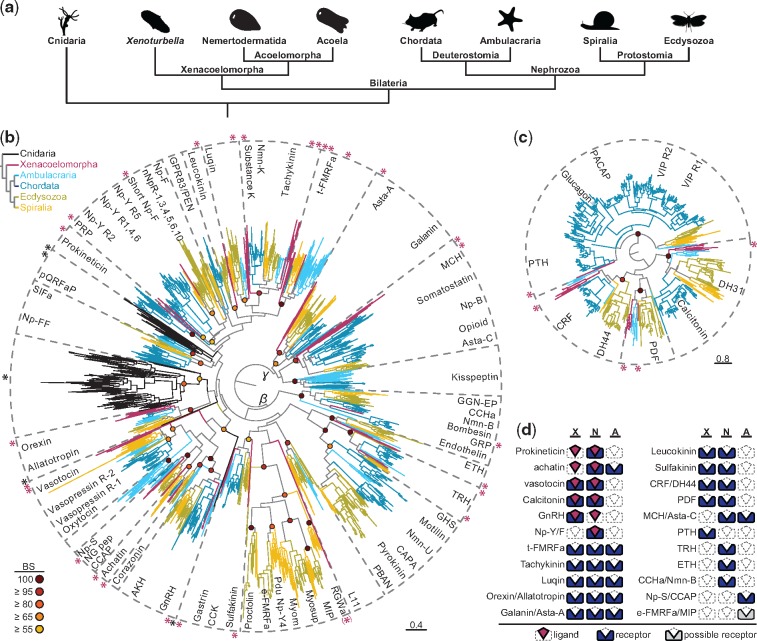
Phylogenetic analysis of neuropeptide GPCRs. (a) Simplified phylogeny of Bilateria with Cnidaria as their sister group. (b) RAxML analysis of rhodopsin type neuropeptide GPCRs. Rhodopsin beta GPCRs are rooted against rhodopsin gamma GPCRs. Bootstrap values of the particular nodes are represented as red-to-yellow circles as shown on the lower left. The scale bar on the lower right indicates amino acids substitution rate per site. Magenta asterisks indicate the position of xenacoelomorph sequences, and black asterisks indicate the position of cnidarian sequences. If more than one monophyletic cluster of xenacoelomorph sequences is present within one receptor type, it is indicated by the corresponding number of asterisks. Dashed lines demarcate orthologous receptor types of different animal groups. Color coding of tree branches is shown on the upper left: Magenta = xenacoelomorphs, blue = chordates, light blue = ambulacrarians, olive = ecdysozoans, yellow = spiralians, black = cnidarians. (c) RAxML analysis of secretin-type neuropeptide GPCRs. Bootstrap support, substitution rate per site, and taxa color coding are depicted as in figure (b). (d) Distribution of conserved bilaterian neuropeptide receptors and ligands in Xenacoelomorpha. Blue boxes show the presence of conserved receptors, whereas the gray boxes display the presence of a possible conserved receptor (boot strap support < 50%). Magenta diamonds show presence of conserved ligand. A, Acoela; a, amide; AKH, adipokinetic hormone; Asta, allatostatin; BS, bootstrap support; CCAP, crustacean cardioaccelatory peptide; CCK, cholecystokinin; CRF, corticotropin releasing factor; DH, diuretic hormone; GGN-EP, GGN excitatory peptide; e-, ecdysozoan; ETH, ecdysis triggering hormone; GHS, growth hormone segretagogue; GnRH, gonadotropin releasing hormone; GRP, gastrin releasing peptide; N, Nemertodermatida; Np, neuropeptide; nNpR, nematode neuropeptide receptor; Nmn, neuromedin; L11 = elevenin; MCH, melanin concentrating hormone; MIP, myoinhibitory peptide; Myosup, myosuppressin; PACAP, pituitary adenylate cyclase-activating polypeptide; PBAN, pheromone biosynthesis activating neuropeptide; PDF, pigment dispersing factor; Pdu, Platynereis dumerilii; NG pep, NG peptide; pQRFaP, pyroglutaminated RFamide peptide; PTH, parathyroid hormone; PRP, prolactin releasing peptide; R, receptor; t-, trochozoan; TRH, thryotropin releasing hormone; VIP, vasoactive intestinal peptide; X, Xenoturbella. Silhouette pictures are downloaded from www.phylopic.org under the Public Domain Dedication 1.0 (CC0 1.0) or Public Domain Mark 1.0 license without any copyright restrictions or were drawn by one of the authors.